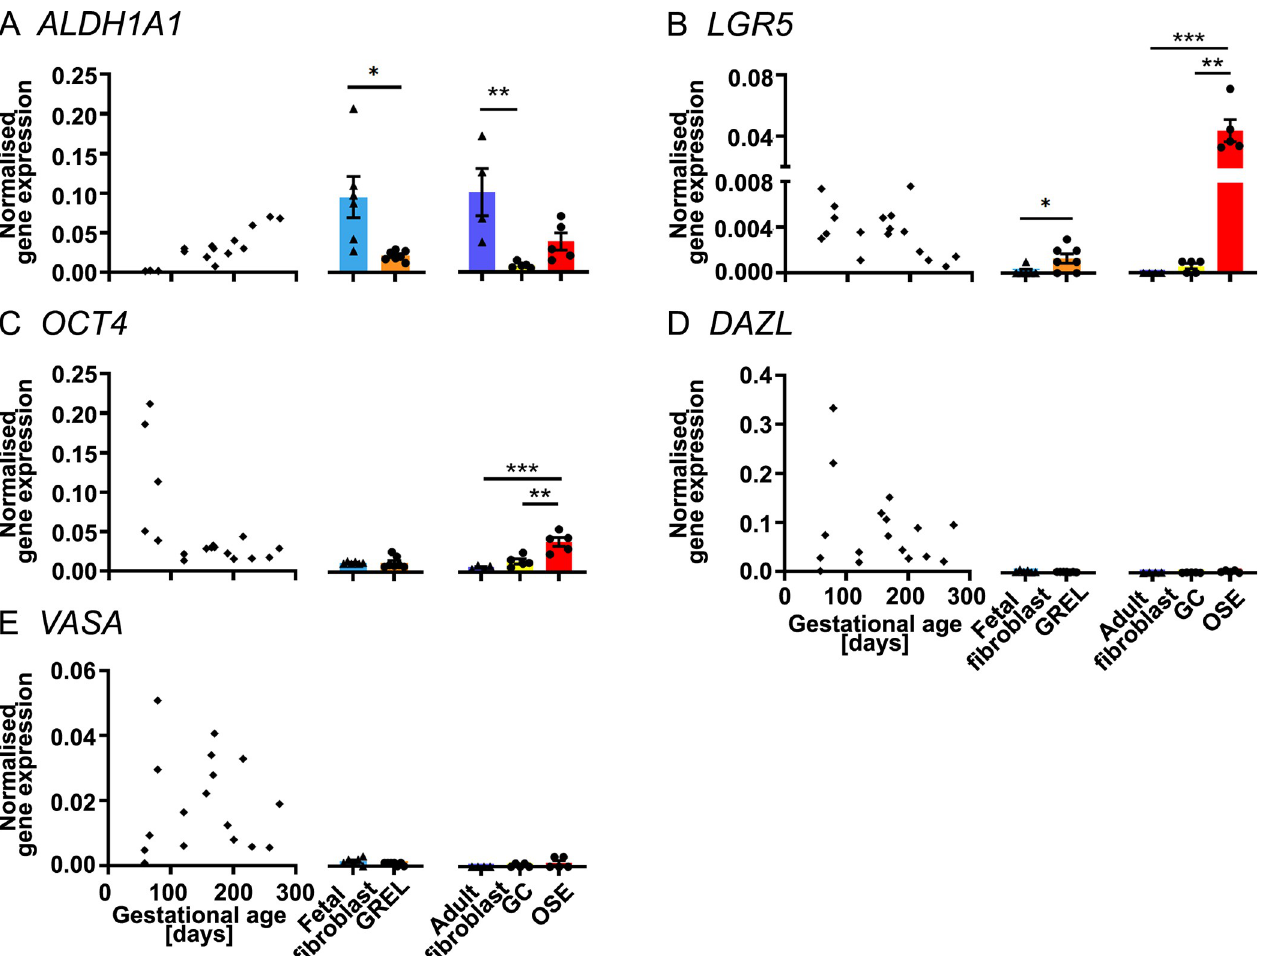
Fig 7. mRNA expression levels of stem and germ cell genes. Scatter plots in each subfigure show gene expression levels in fetal ovaries at different gestational ages (n = 27) and are from our previous publications [30, 31]. Gene expression levels in cultured GREL cells (n = 7; gestational ages are 51, 56, 73, 110, 110, 127 and 177 days) and fetal fibroblasts (n = 6; gestational ages are 51, 73, 101, 110, 110 and 177 days) are presented as mean ± SEM (normalised to PPIA and RPL32 ) in the middle graph of each subfigure. The differences between GREL cells and fetal fibroblasts were analysed with Student’s t-tests. Data of gene expression in adult fibroblasts (n = 4), granulosa cells (GC; n = 5) and ovarian surface epithelium (OSE; n = 5) are presented as mean ± SEM (normalised to PPIA and RPL32 ) in the graph on the right side of each subfigure. Significant differences among the three adult cell types were determined by one-way ANOVA with Tukey’s post-hoc test. � P < 0.05, �� P < 0.01, ��� P <